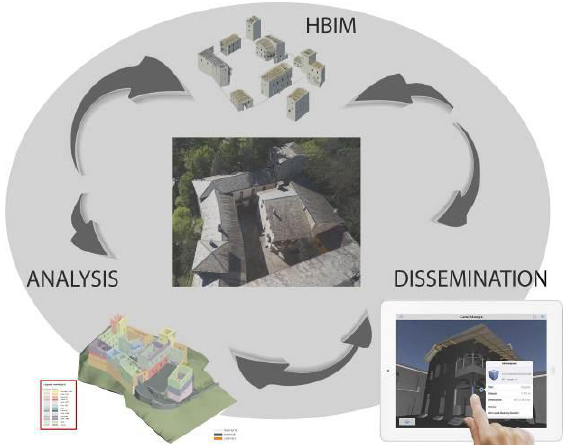
Fig. 2. The creation of a HBIM can be exploited for different purposes and user